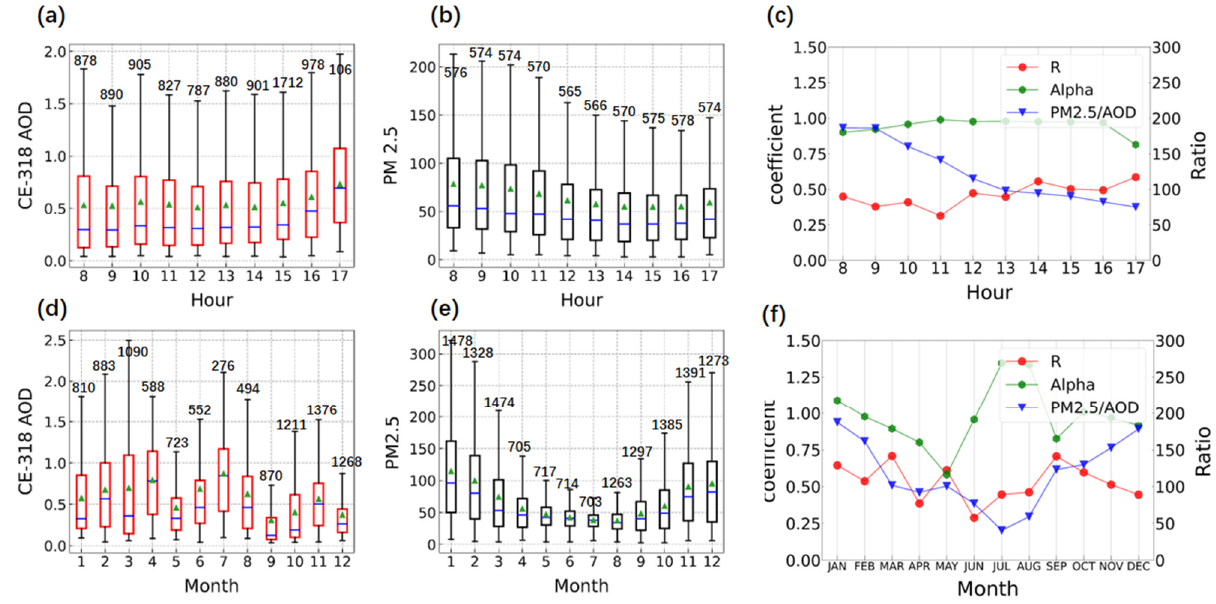
Figure 8. Daily variation boxplot of the solar photometer AOD ( a ) in Gucheng and PM 2.5 ( b ) at the CNEMC(China National Environmental Monitoring Centre) air quality site in Baoding (Huadian II) during the August 2017 to March 2019 period, and seasonal variation boxplot ( d , e ).The red and black boxes represent the upper and lower quartiles, the black line represents the upper and lower edges of the data, and the blue horizontal line inside the box represents the data median, the green triangle indicates the data mean. Correlation coefficient R2 of AOD and PM 2.5 , Ångström exponent Alpha of AOD, PM 2.5 /AOD daily variation ( c ), and seasonal variation ( f ).